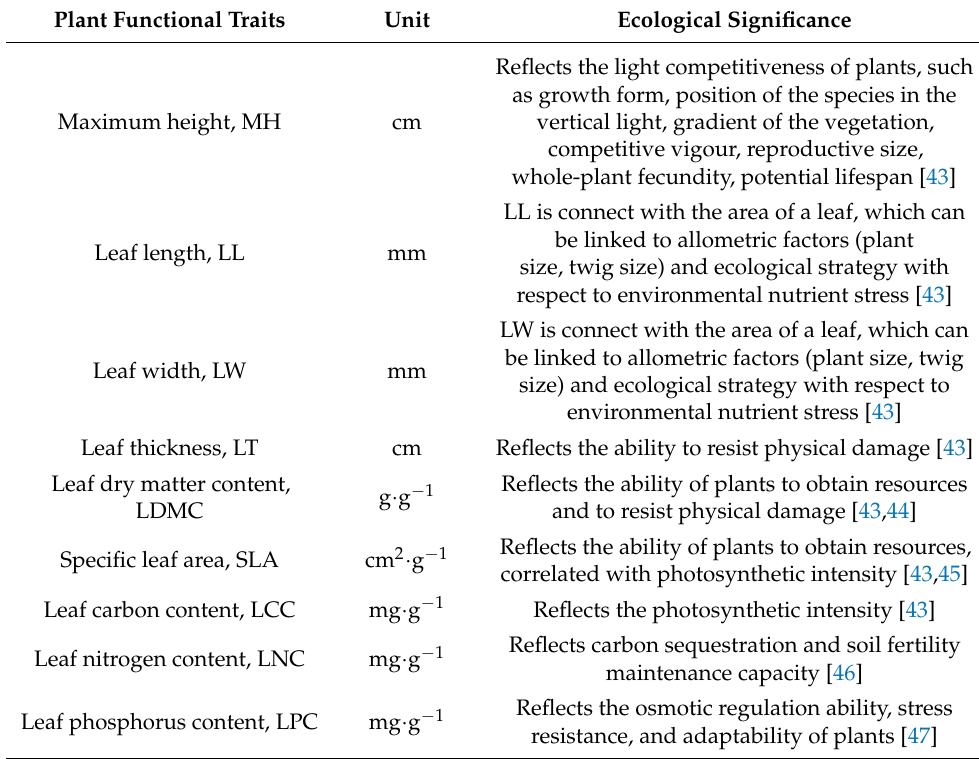
Table 2. Nine plant functional trait indicators, unit of measure, and their ecological significance. Plant Functional Traits Unit Ecological Significance Reflects the light competitiveness of plants, such as growth form, position of the species in the vertical light, gradient of the vegetation, Maximum height, MH cm competitive vigour, reproductive size, whole-plant fecundity, potential lifespan [43] LL is connect with the area of a leaf, which can be linked to allometric factors (plant Leaf length, LL mm size, twig size) and ecological strategy with respect to environmental nutrient stress [43] LW is connect with the area of a leaf, which can be linked to allometric factors (plant size, twig Leaf width, LW mm size) and ecological strategy with respect to environmental nutrient stress [43] Leaf thickness, LT cm Reflects the ability to resist physical damage [43] Reflects the ability of plants to obtain resources Leaf dry matter content, g · g − 1 and to resist physical damage [43,44] LDMC Reflects the ability of plants to obtain resources, Specific leaf area, SLA cm 2 · g − 1 correlated with photosynthetic intensity [43,45] Leaf carbon content, LCC mg · g − 1 Reflects the photosynthetic intensity [43] Reflects carbon sequestration and soil fertility mg · g − 1 maintenance capacity [46] Leaf phosphorus content, LPC mg · g −